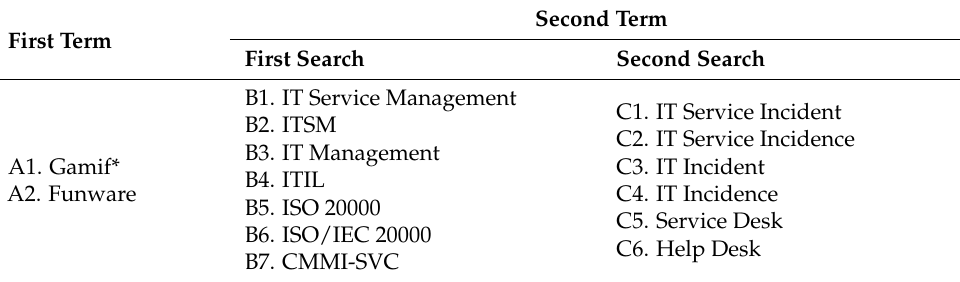
Table 3. Search terms to search the primary studies.